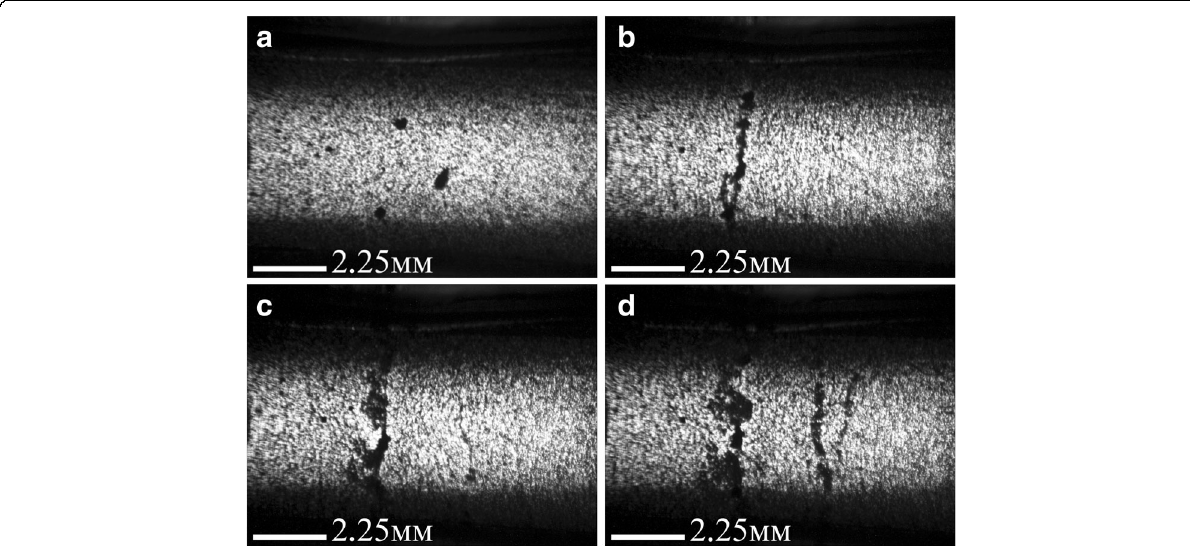
Fig. 1 Optical images of electrical “ breakdown ” formation in 0.05 wt% GNPs/Larit 285 composite under AC electric field action of strength of 36 kV/m, frequency of 15 kHz (embedded electrodes): a — before electric field action; b — after 100 s; c — after 140 s; d — after 160 s of electric field action. Image size 10.8 × 8.0 mm 2